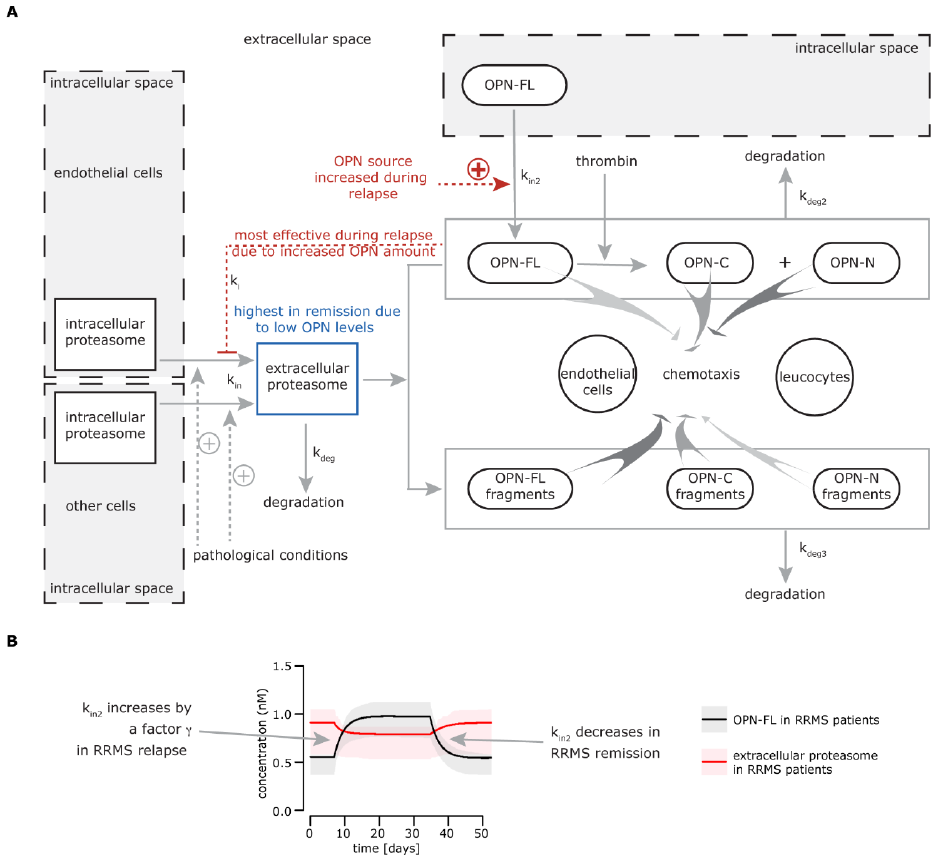
Figure 1. Extracellular osteopontin-(OPN) proteasome circuit model . ( A ) The biological model behind